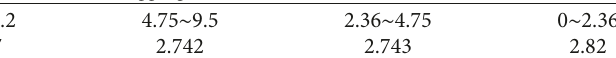
Table 3: Apparent densities of basalt aggregates.